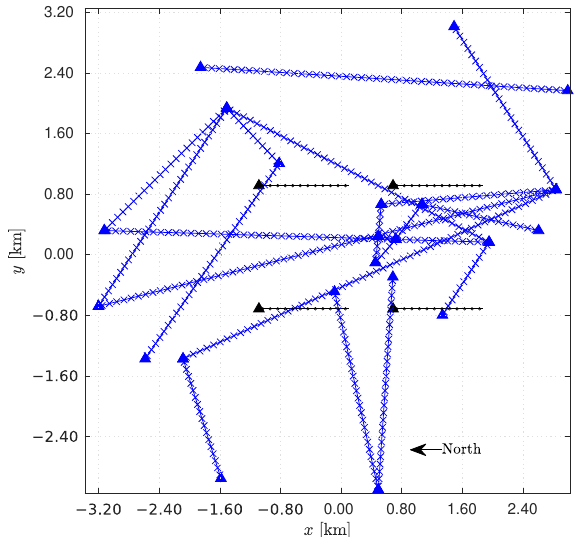
Figure 2. Network topology used for numerical performance evaluation via computer simulation. Legend: blue lines: CML links; black lines: ground projection of BSLs’ wet segments; ‘x’ marks: data points taken by the algorithm on CML links; ‘ ◦ ’ marks: ground projection of data points taken by the algorithm on BSLs’ wet segments; ‘ ’ marks: receivers. Notice: CMLs are full duplex links with receivers on both endpoints of each link; BSLs are one-way links with receivers only on the ground endpoint of the